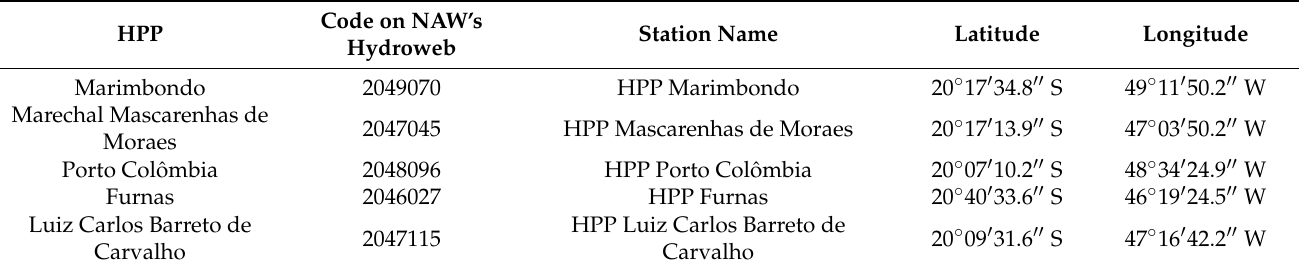
Table 2. Details of selected rainfall stations operated by Furnas are available on the Hydroweb platform of the National Water and Sanitation Agency.